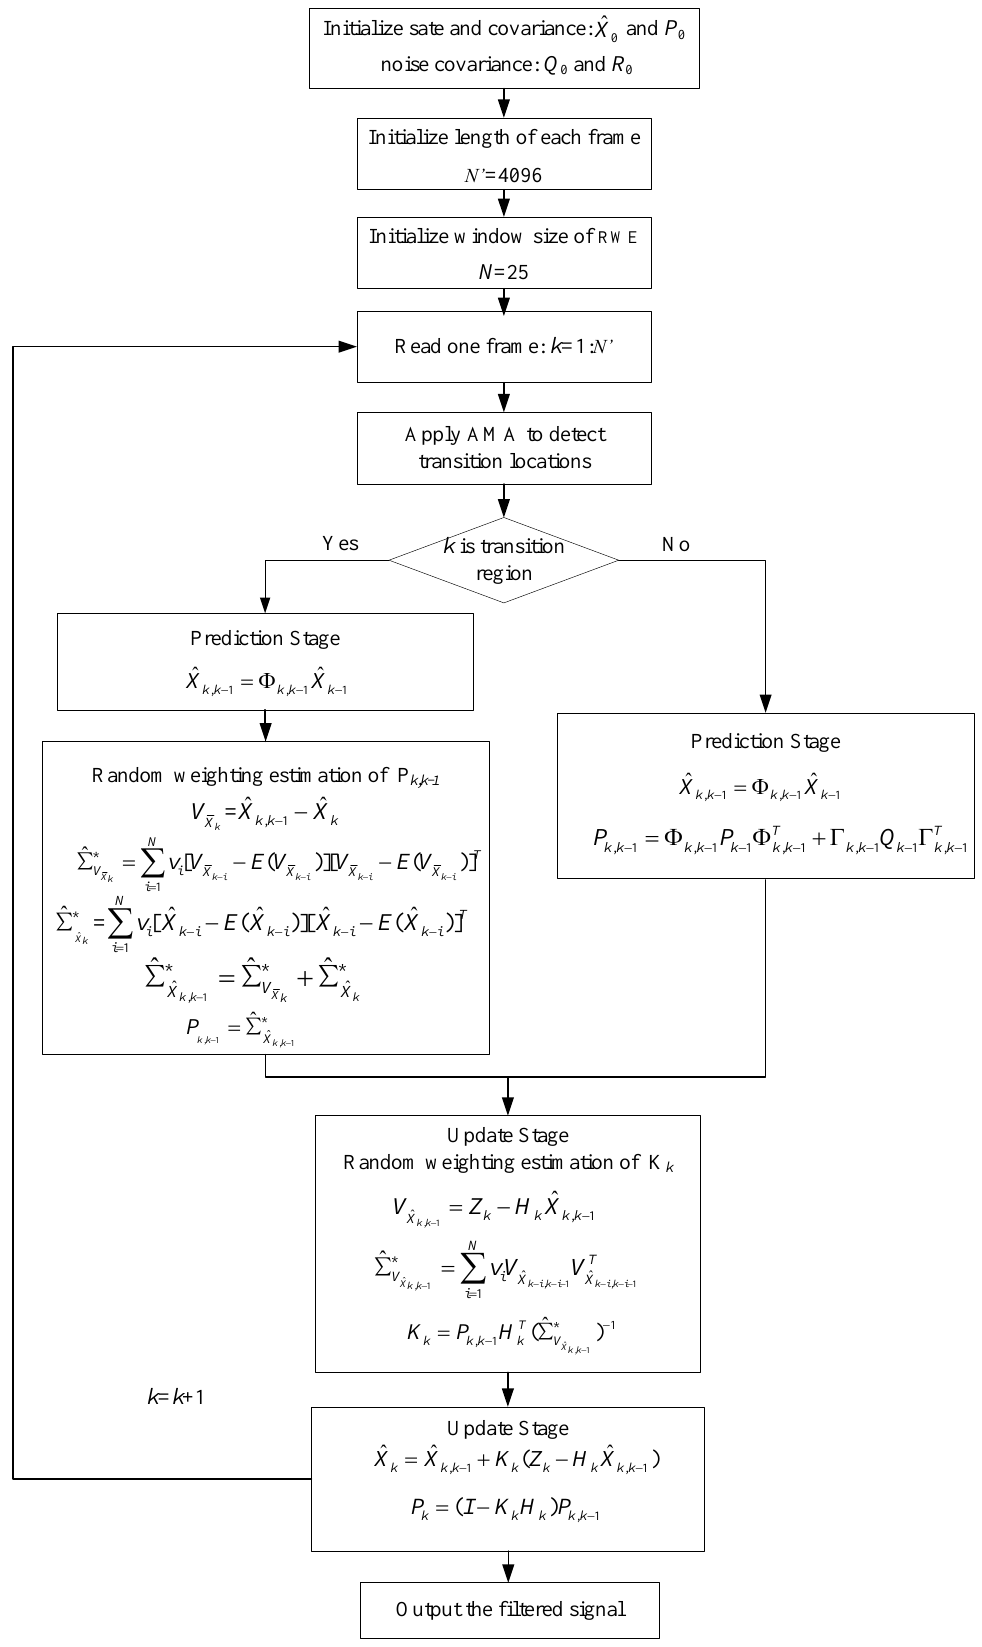
Figure 2. Operation of the proposed AMA-RWE-DFAKF